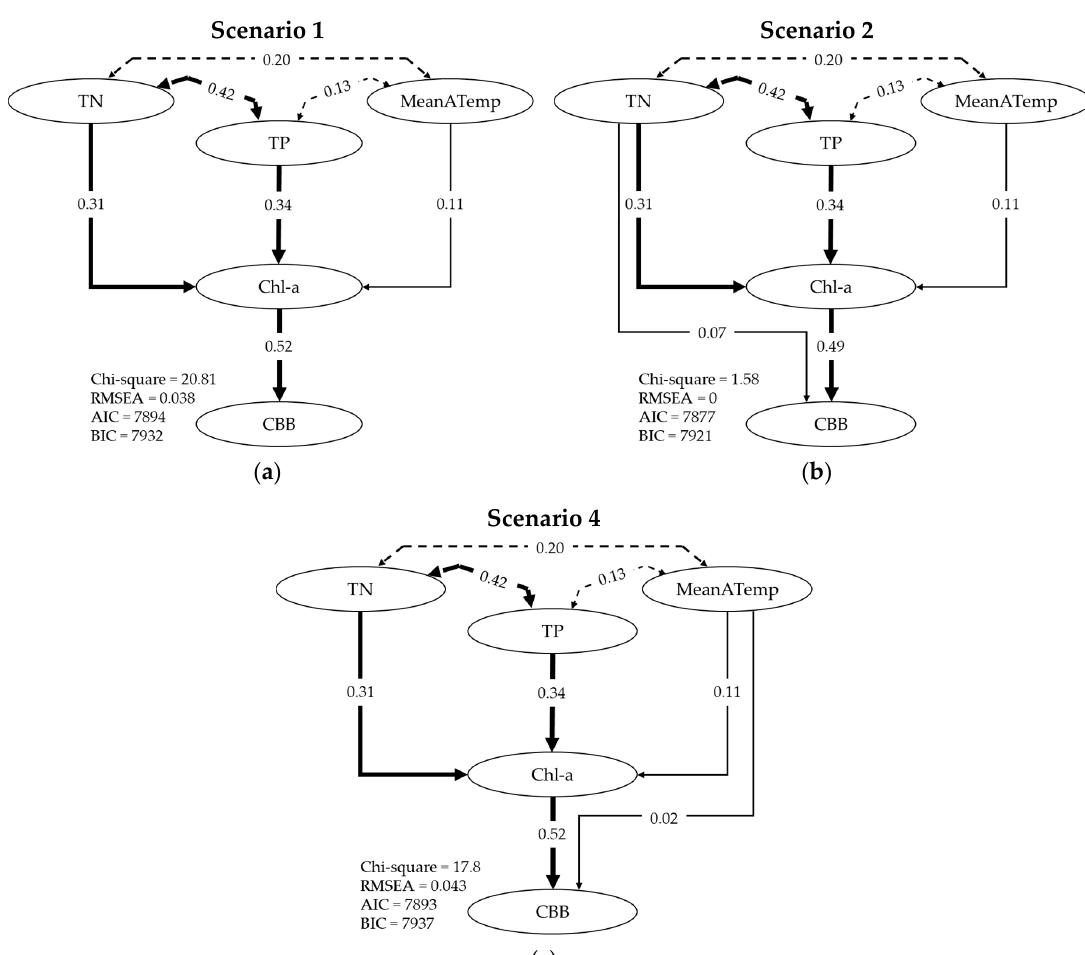
Figure 5. Schematic representation of path analysis scenarios predicting CBB using the main variables TN, TP, MeanATemp and Chl-a. Standardized path coefficients and relevant statistics are shown for each scenario. ( a ) TN, TP and MeanATemp have indirect effects while Chl-a has a direct effect on CBB. ( b ) Similar to ( a ) with the addition of TN having a direct effect on CBB. ( c ) Similar to ( a ) with the addition of MeanATemp having a direct effect on CBB.